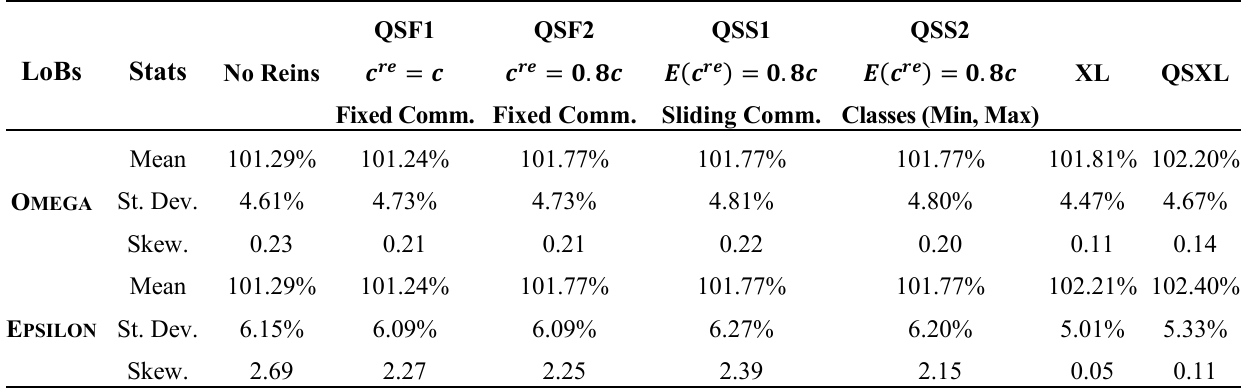
Table 7. Characteristics of Combined Ratio distribution for both insurers (Total Portfolio— Gross and Net